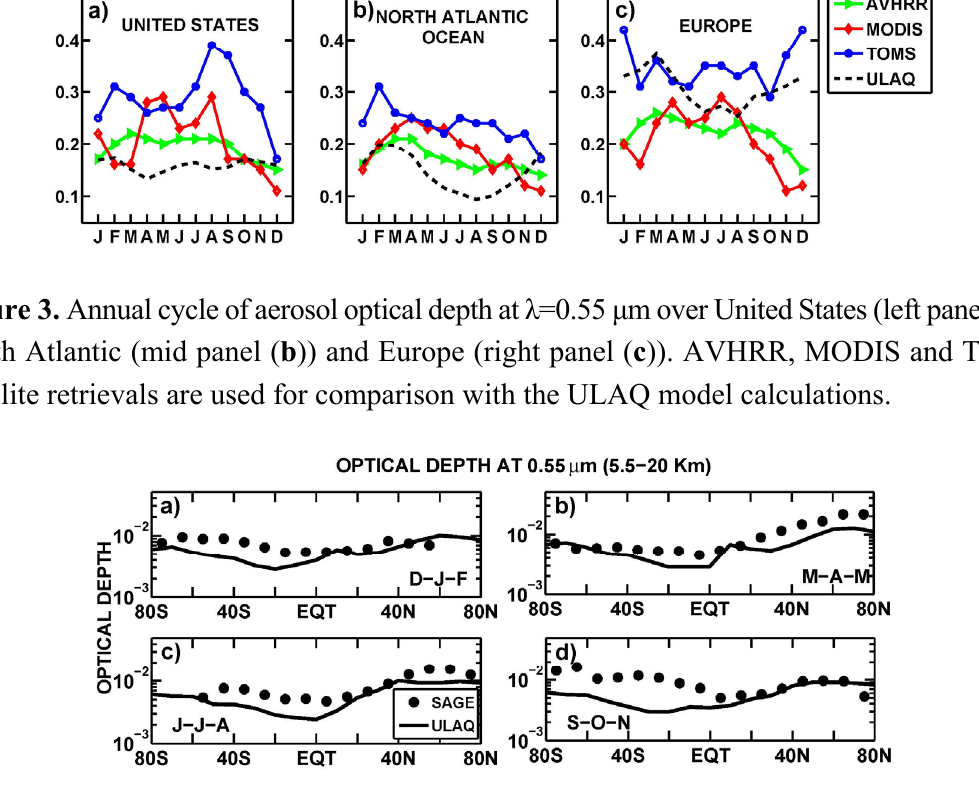
Figure 4. ULAQ model calculations (solid line) and SAGE-II derived values (circles) of aerosol optical depth at λ = 0.55 μ m, integrated between 5.5 km and 20 km altitude, for winter (upper left panel ( a )), spring (upper right panel ( b )), summer (bottom left panel ( c )) and fall months (bottom right panel ( d )) (average